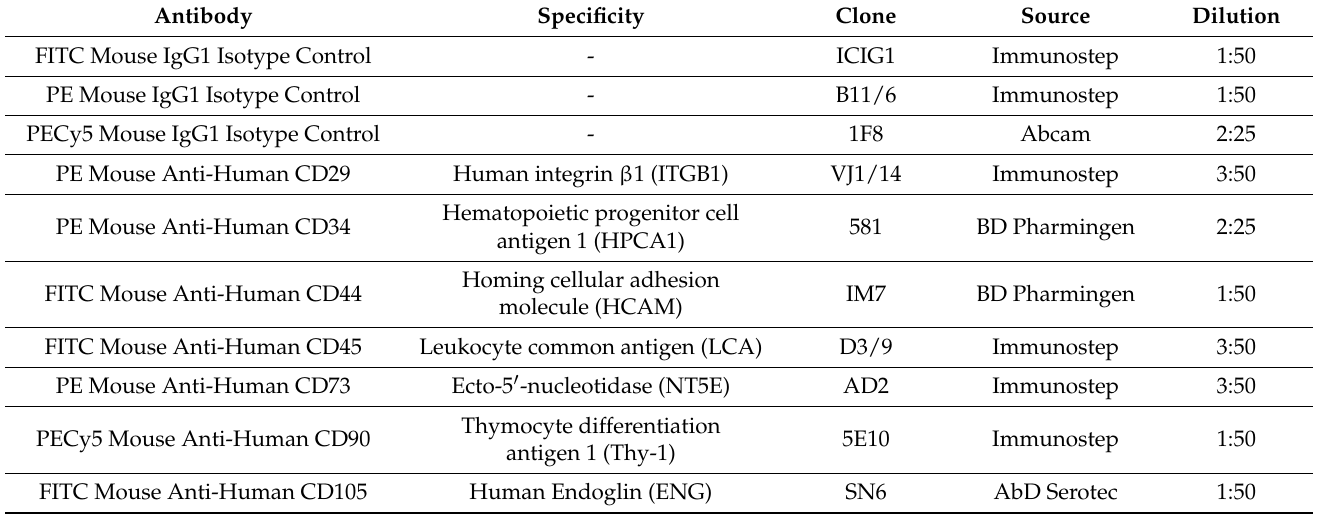
Table 2. Isotype controls and antibodies conjugated with fluorescein isothiocyanate (FITC), phycoerythrin (PE) or PE/Cy5 used for flow cytometry. Antibody